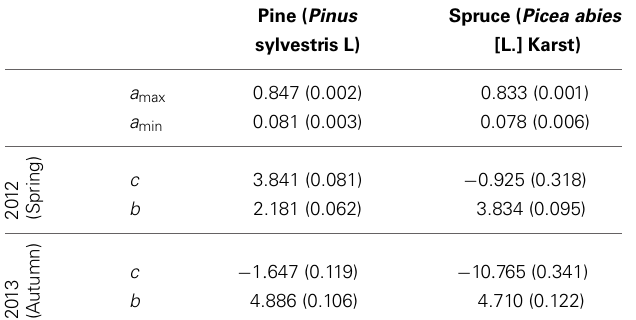
Table 3 | Parameter estimates and standard errors (in parentheses) for the fixed effects in the non-linear mixed model using a 7-day sliding average of daily mean temperature as a predictor.